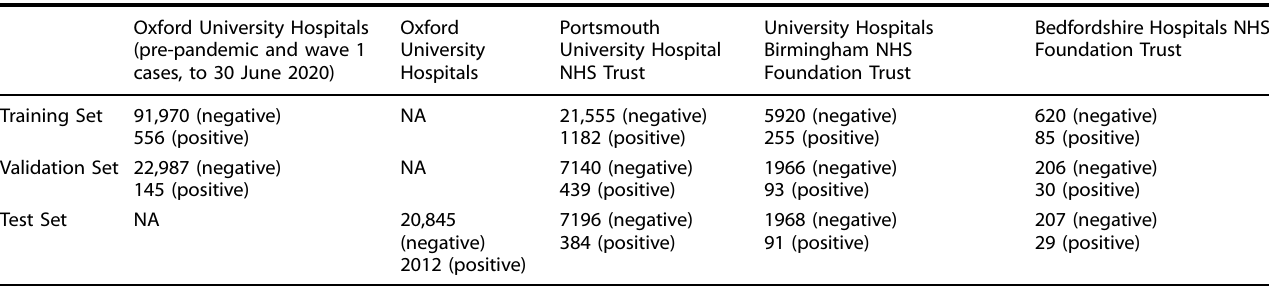
Table 2. Training, validation, and test set distributions.